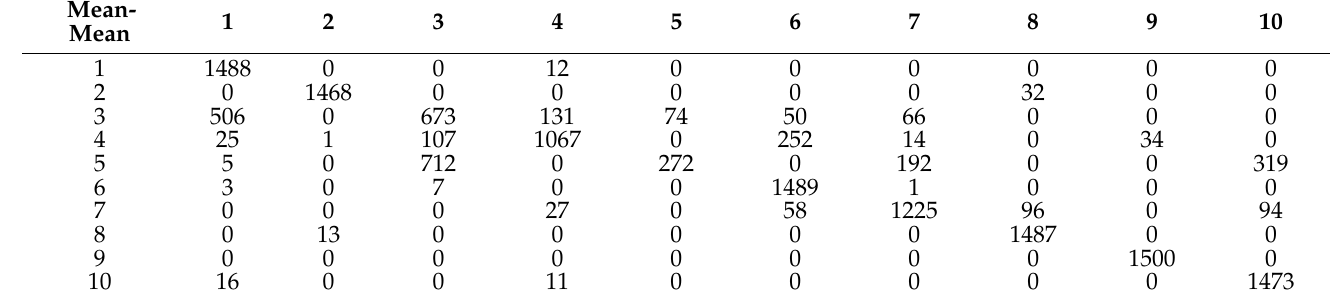
Table 7. The confusion matrix of hand gesture intention recognition by VGG-16 CNN deep learning with wavelet image fusion of the merge type of “mean-mean” on the recognition system test. Mean-Mean